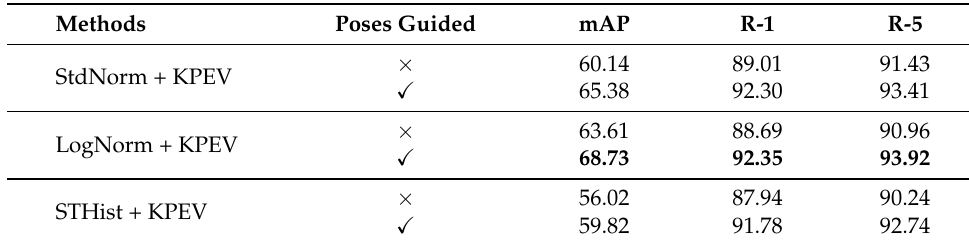
Table 8. Comparisons (%) of performance of our KPGST approach on the VeRi-776 dataset. The best results are shown in bold.